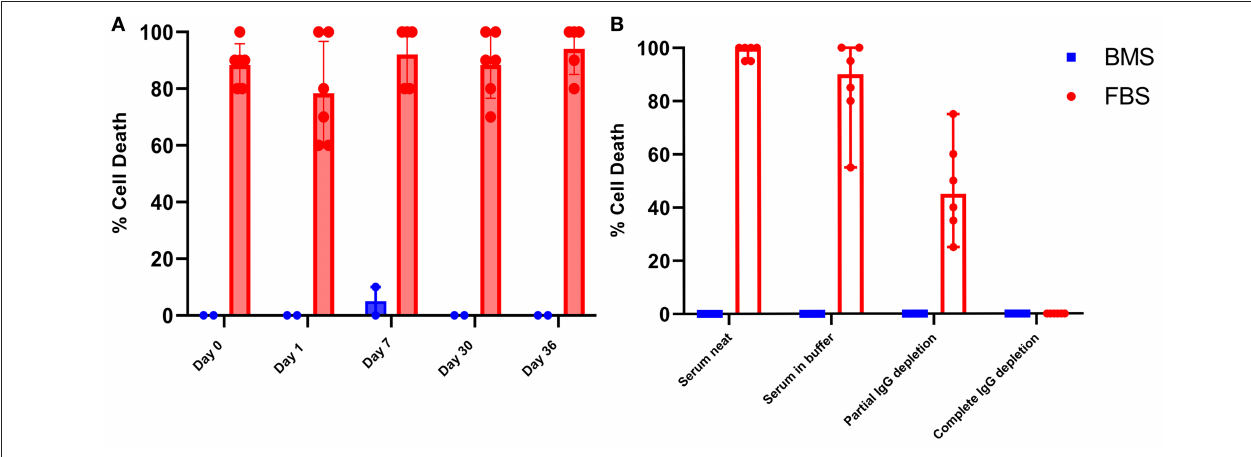
FIGURE 6 | Antibodies against bovine proteins are present in serum and synovial fluid, and cause death of FBS prepared MSCs. (A) Synovial fluid collected on days 0, 1, 7, 30, and 36 produced significant cell death when combined with autologous FBS-MSCs. (B) To demonstrate that MSC cell death was antibody mediated, serum collected on day 35 was depleted of immunoglobulins partially and completely. All serum samples were combined with either BMS-MSCs or FBS-MSCs. There was no death of BMS-MSCs, there was significant cell death of FBS-MSCs both neat and in buffer, a reduction of cell death with partial IgG depletion, and elimination of cell death with complete IgG